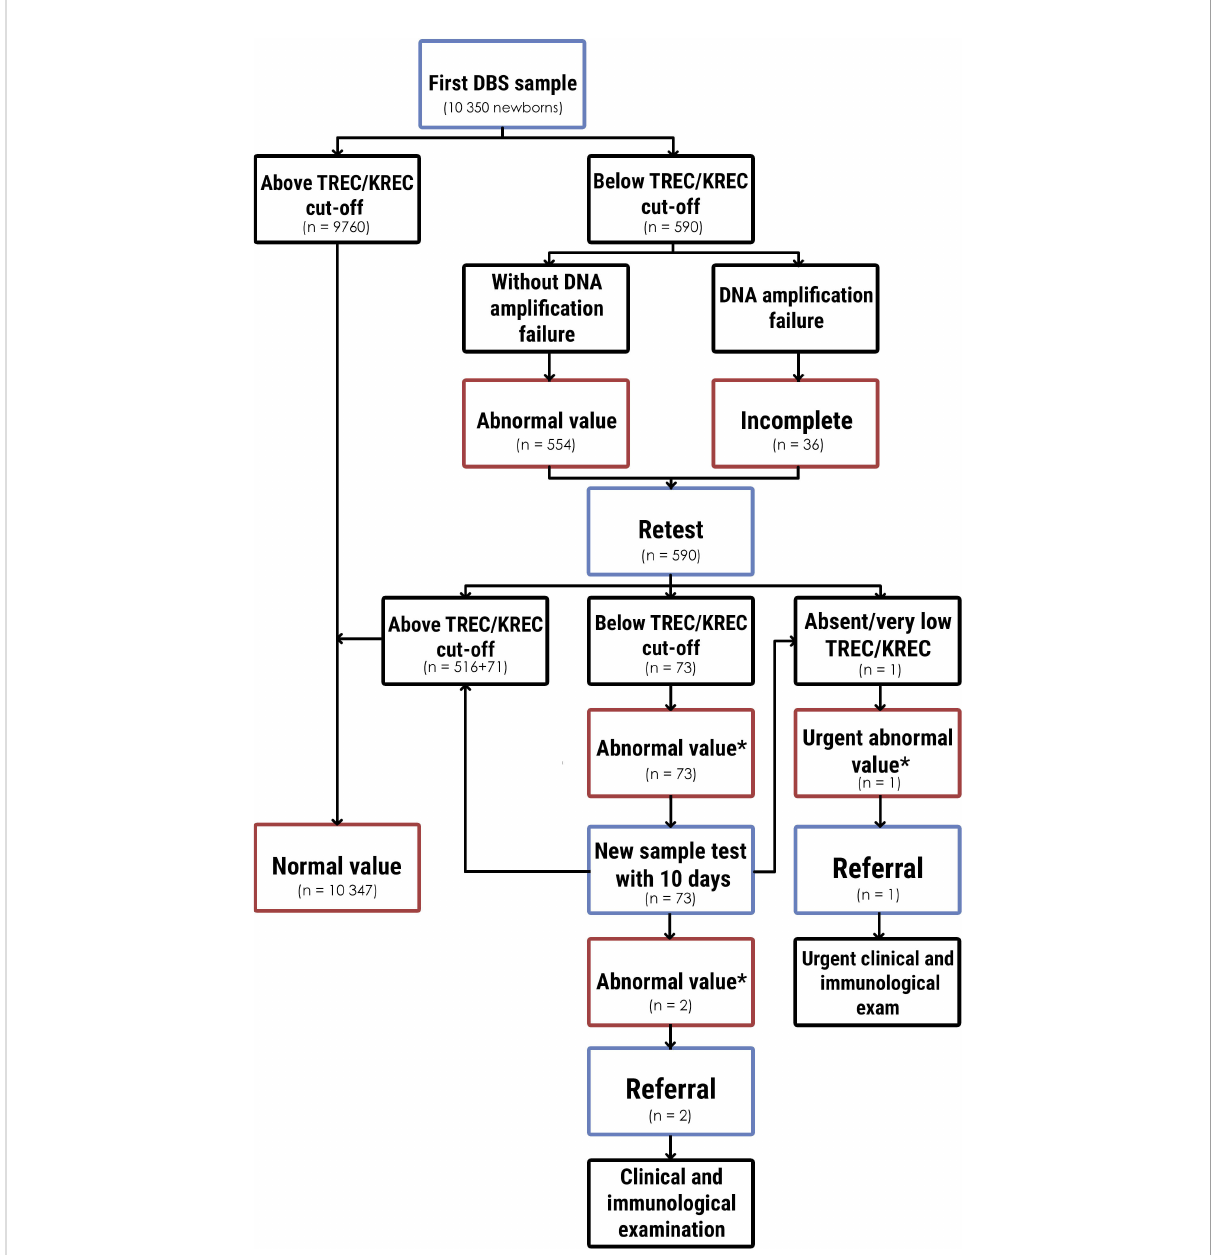
FIGURE 1 Newborn screening diagnostic algorithm for determination SCID and T- and B-lymphopenia and results. * - below TREC/KREC cut-off without DNA ampli fi cation